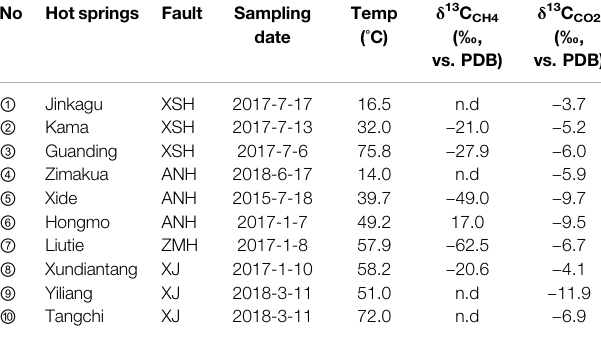
TABLE 3 | The δ 13 C CO2 and δ 13 C CH4 values of bubbling hot-spring gases in the XXFS. No Hotsprings Fault